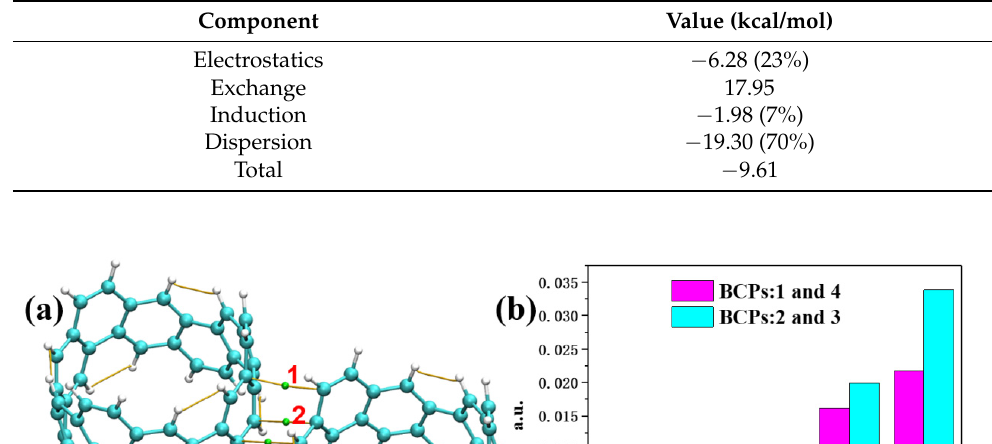
Table 2. The energy of different physical components and total energy of the interaction between [6, 6] CNB dimer based on SAPT energy decomposition, in kcal/mol.